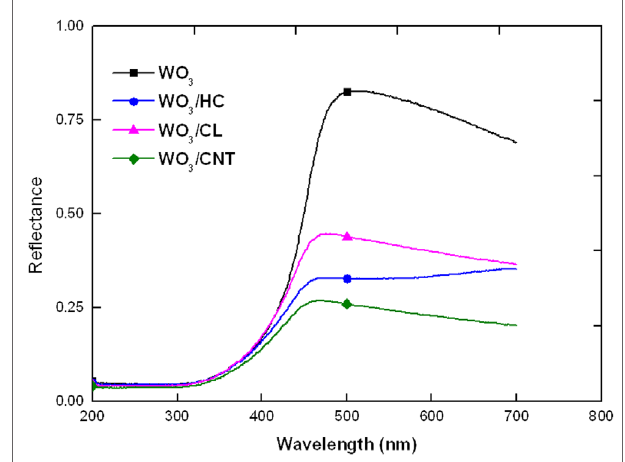
FigUre 2 | Diffuse reflectance spectra of the studied photocatalysts .